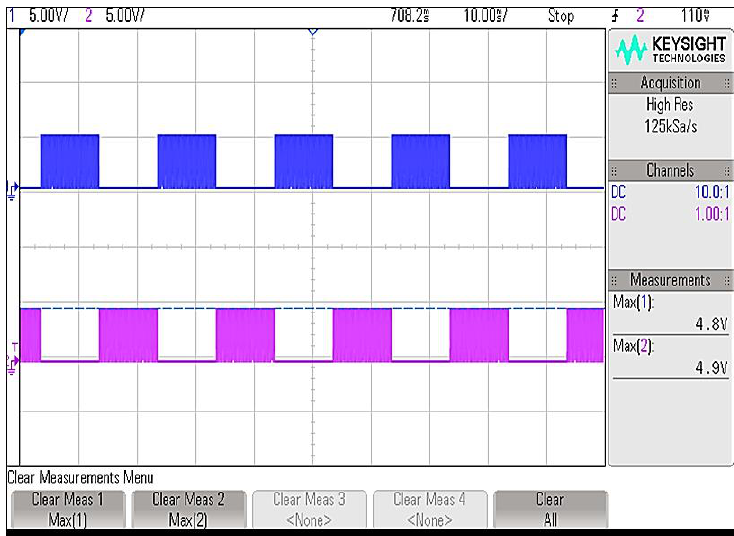
Figure 17. Voltage source inverter Pulse Width Modulation (PWM) pulses.